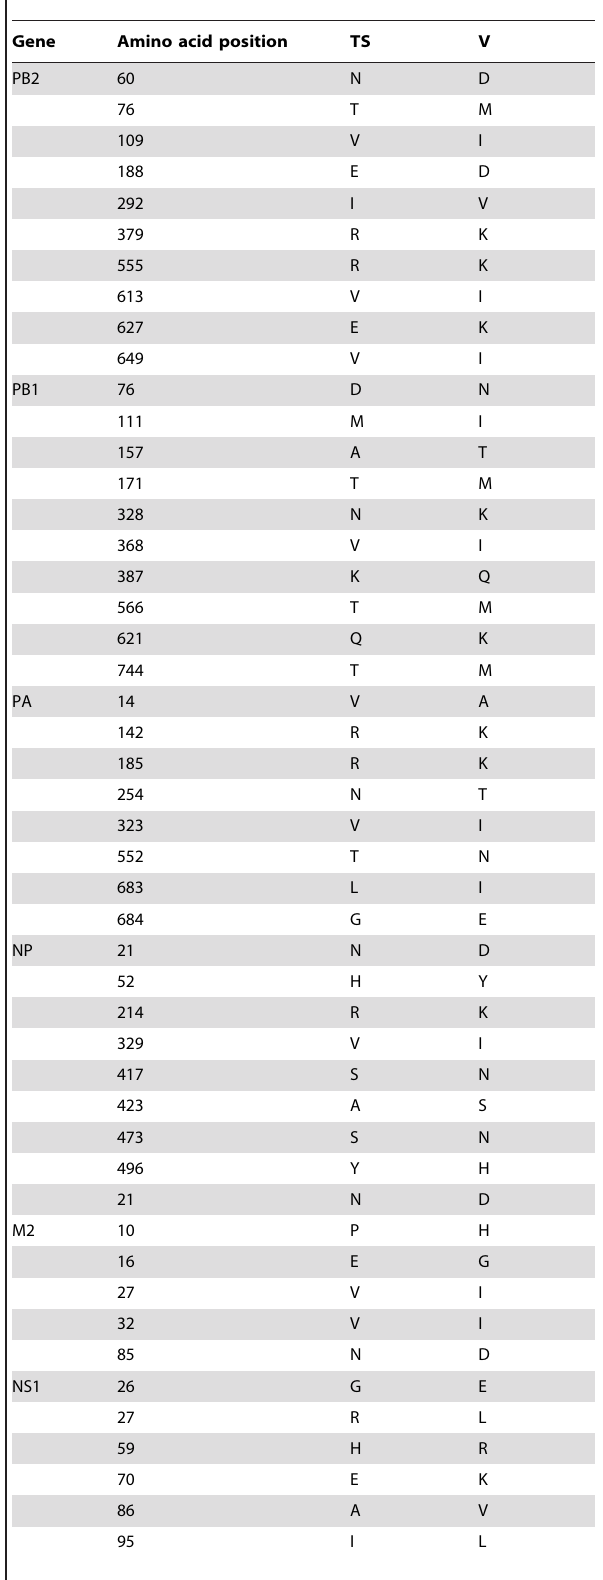
Table 3. Amino acid differences of internal gene proteins between avian influenza H9N2 TS and V viruses.